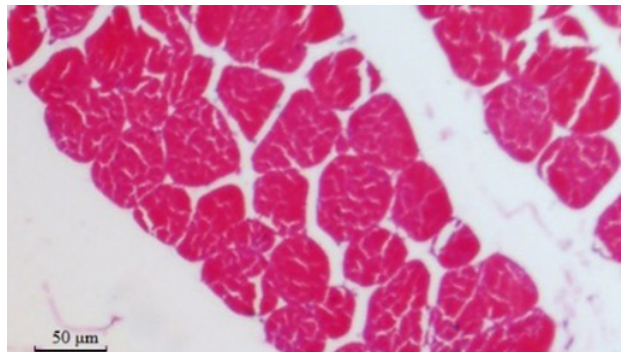
Figure 4. Paraffin section of breast muscle in 10-week-old geese. Muscle fibers were cross-cut. The section was formalin-fixed, paraffin-embedded and counterstained with Mayer’s hematoxylin. In the section, red denotes single muscle fibers and white denotes in-muscle fat. Magnification: